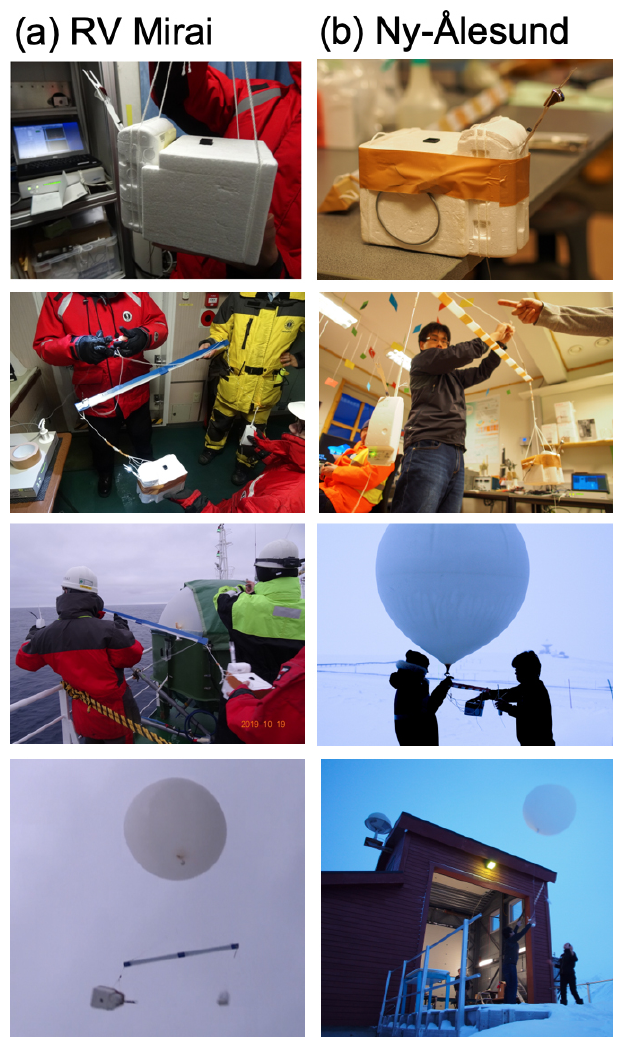
Figure 1. Photographs of the CPS sonde operation at the (a) RV Mirai in October 2019 and (b) Ny-Ålesund in March 2020. The CPS housing within a black inlet duct on top is connected to the Meisei RS-11G radiosonde. During the 2019 and 2020 campaigns, the Vaisala RS41-SGP was attached to the opposite side of the rod.